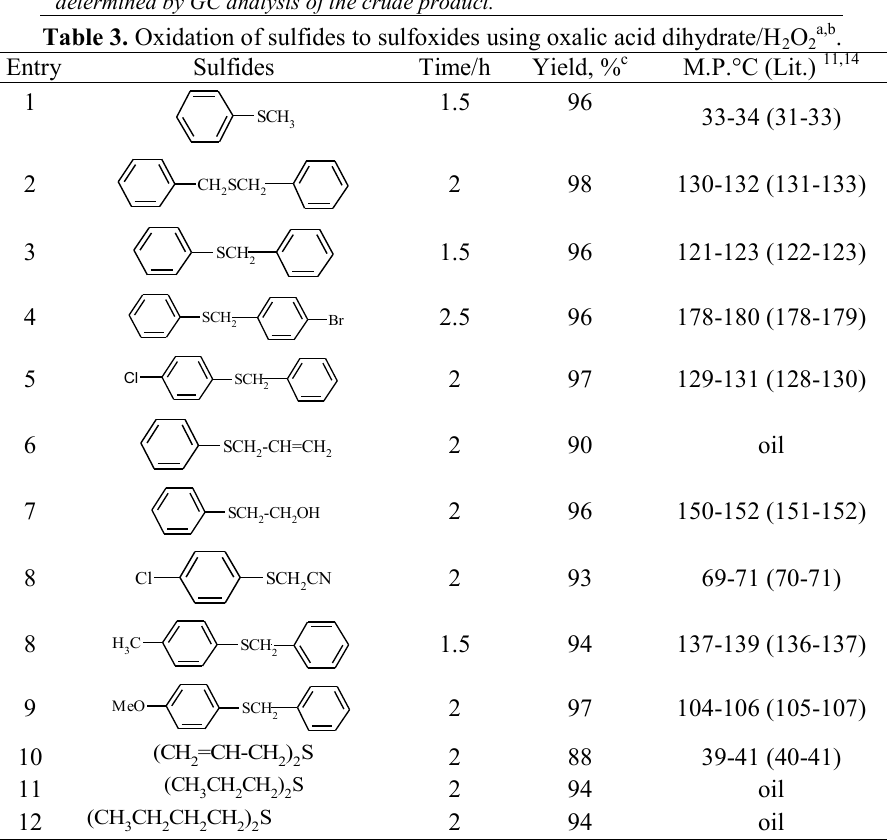
a All the products were characterized by IR, 1 H-NMR spectra and comparison with